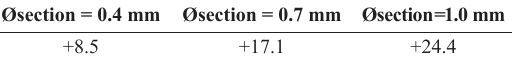
Table 5. Prototype oversizing percentage resulted from the prototype process comparing with the CAD models. Prototype internal perimeter cell oversizing